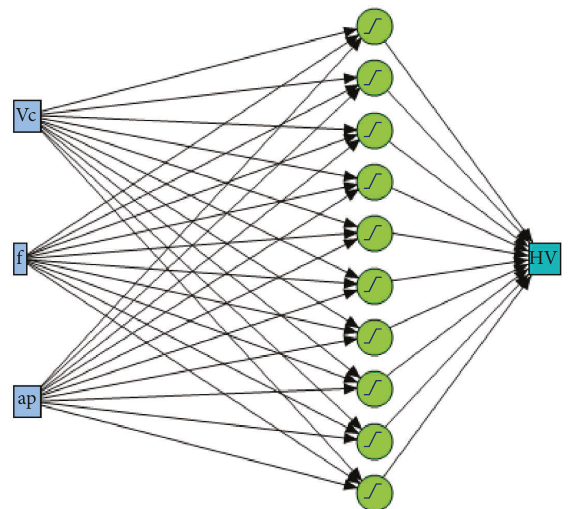
Figure 6: The optimal network structure for HV